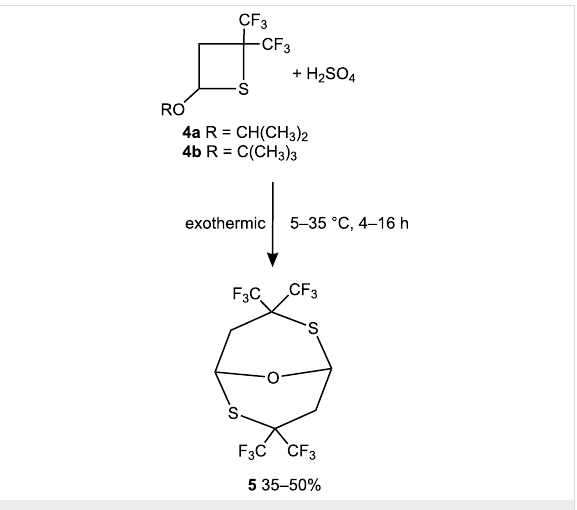
Scheme 6: Reaction of thietanes 4a , b with H 2 SO 4 to generate 5